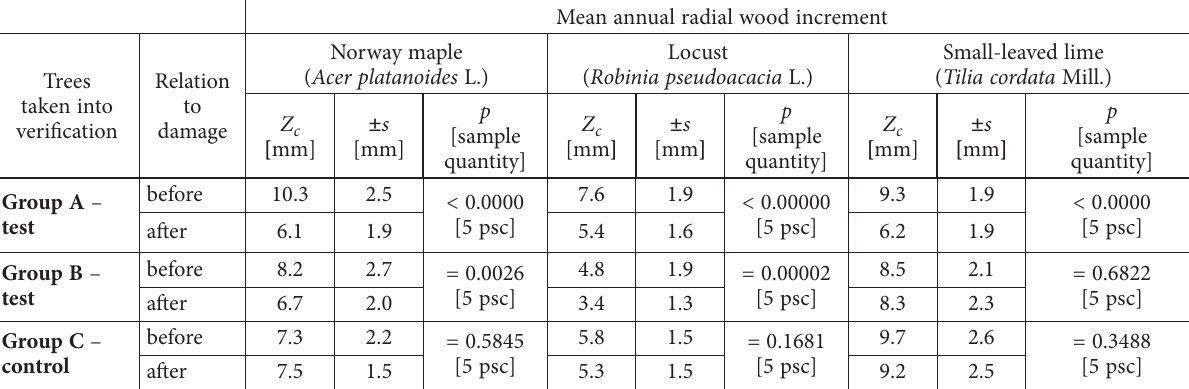
Table 2. The verification of the effectiveness of the circumference measurements (Table 1): the response of radial wood increment [resistograph] to the impact of earthworks due to park’s road system modernization for the three most abundant tree species